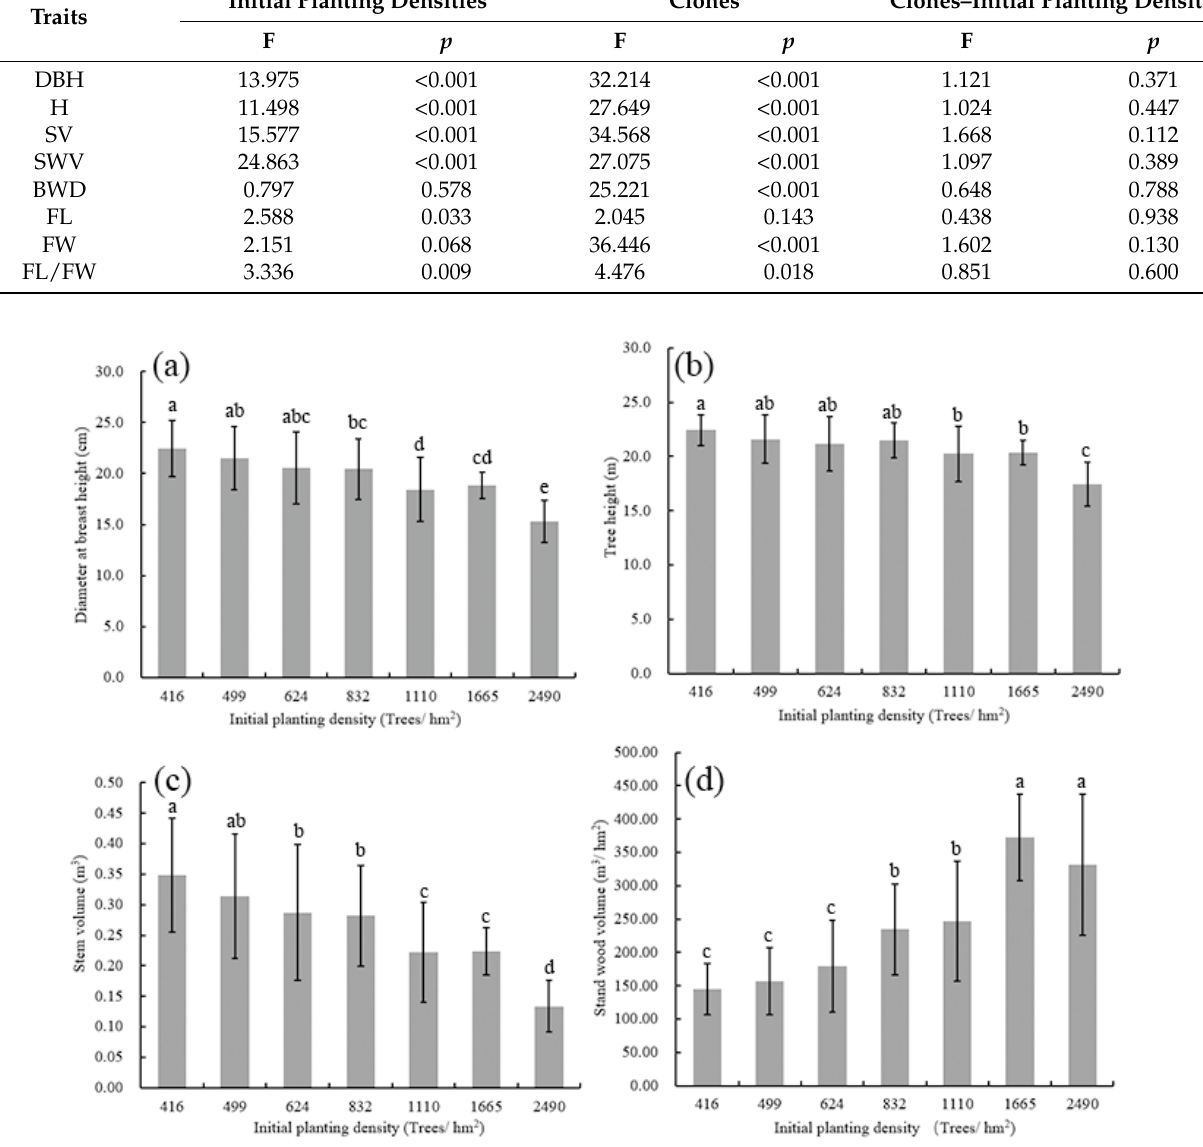
Figure 1. The effects of initial planting density on the growth traits of triploid Chinese white poplar: ( a ) The effects of initial planting density on the DBH. ( b ) The effects of initial planting density on the H. ( c ) The effects of initial planting density on the SV. ( d ) The effects of initial planting density on the SWV. Lowercase letters indicate significance at the p < 0.05 level.